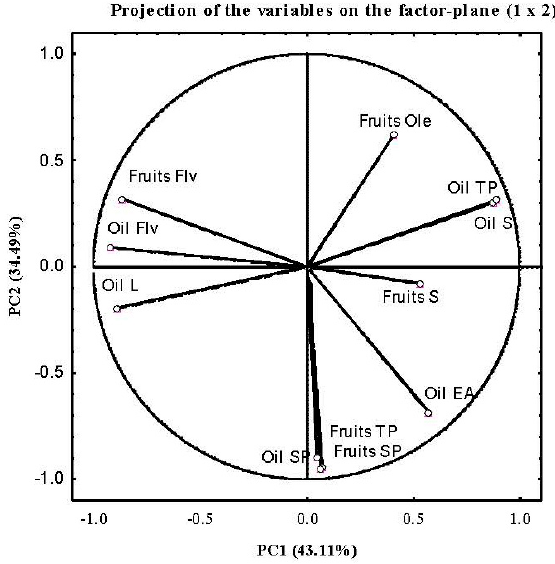
Figure 3. Projection on the factorial plane of olive and oils variables. Ole (oleosides), TP (total phenols), S (secoiridoids), EA (elenolic acid), SP (simple phenol), Flv (flavonoid) and L (lignans).